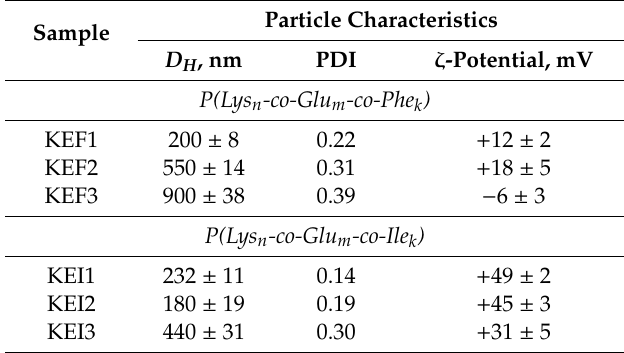
Table 3. Characteristics of polypeptide nanoparticles obtained (DLS, in 0.01 PBS, pH 7.4).